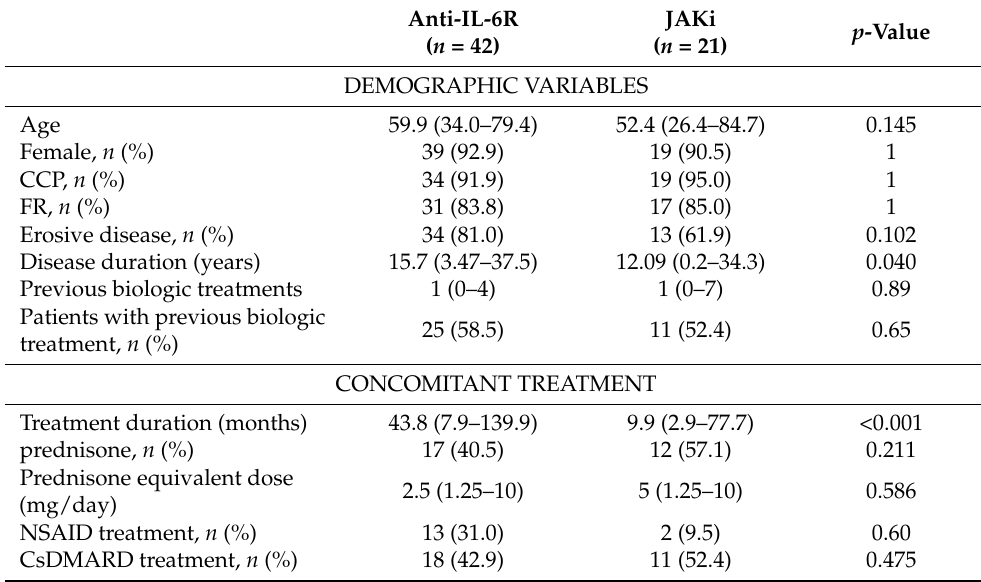
Table 1. Demographic characteristics of patients by therapeutic group.